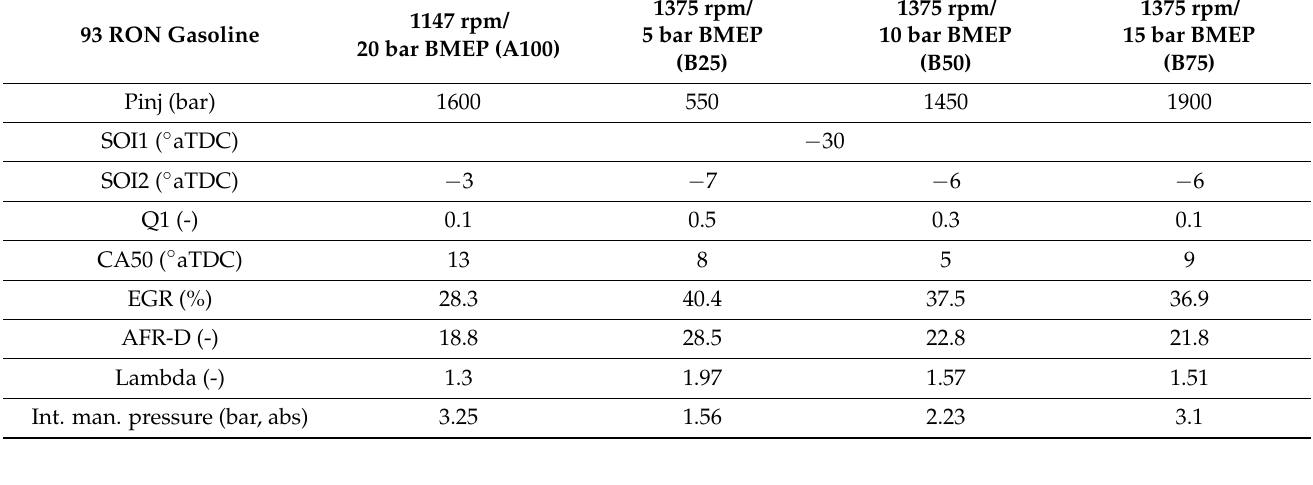
Table 4. Main GCI operating boundary conditions at the four test points.